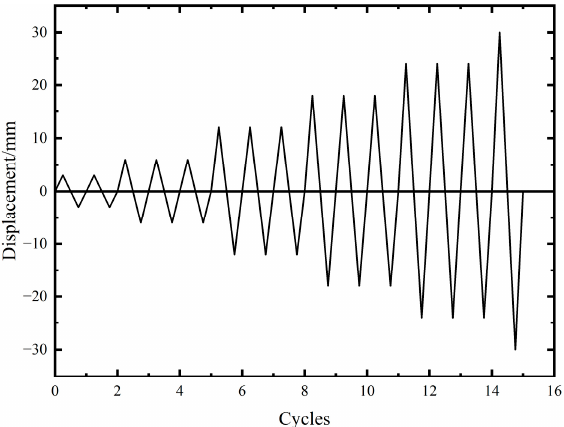
( b ) Figure 6. Schematic of the measurement layout: ( a ) the arrangement of strain gauges on the compo- site wallboard; ( b ) the arrangement of strain gauges on the C-shaped steel. 3.4. The Loading Scheme The force-displacement hybrid control approach was chosen in this paper. The load- ing protocol is shown in Figure 7. The first-to-third displacement levels were performed in load control mode, with one cycle applied at each displacement level. Displacement